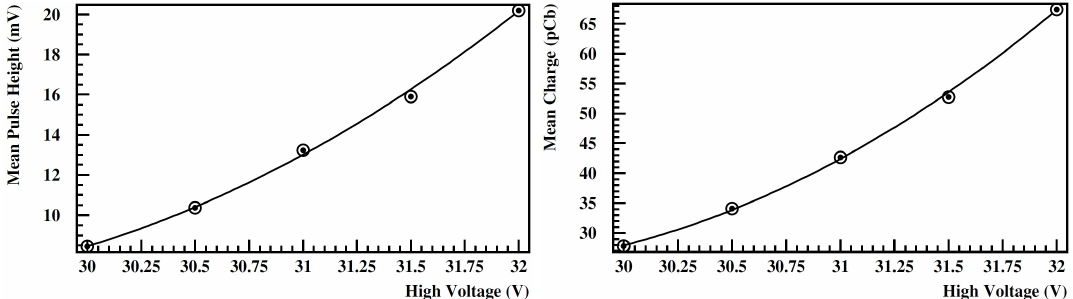
Figure 6. The mean of the pulse height ( left ) and charge ( right ) distributions as a function of the SiPM power supply voltage. The mean is estimated as the mean of the Landau probability distribution function (PDF), which better fits the experimental distribution acquired. The Landau PDF describes the energy loss of relativistic charged particles by ionization of the medium (scintillator